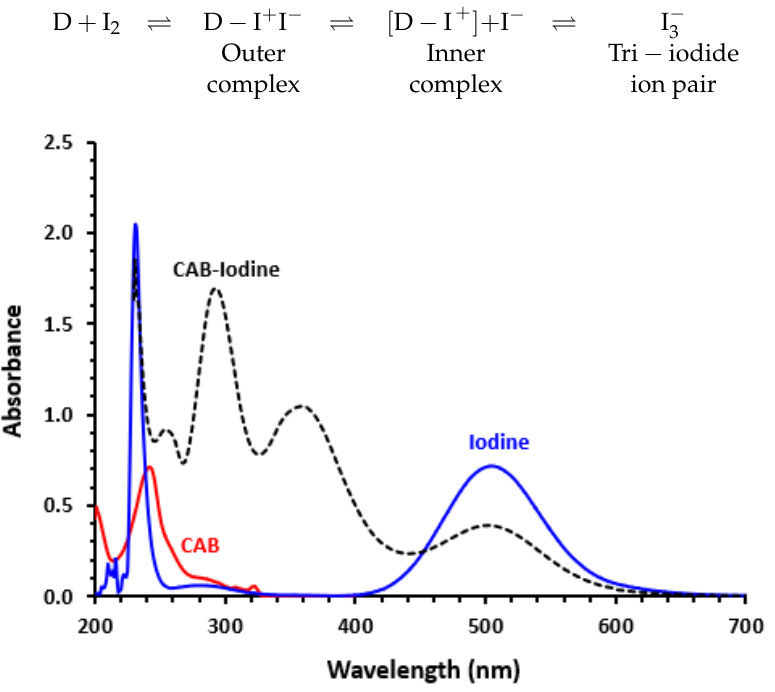
Figure 2. The absorption spectra of CAB (1.99 × 10 − 5 M), iodine (1.58 × 10 − 3 M), and a reaction mixture of CAB (3.99 × 10 − 5 M) with iodine (1.58 × 10 − 3 M). All solutions were in dichloromethane.